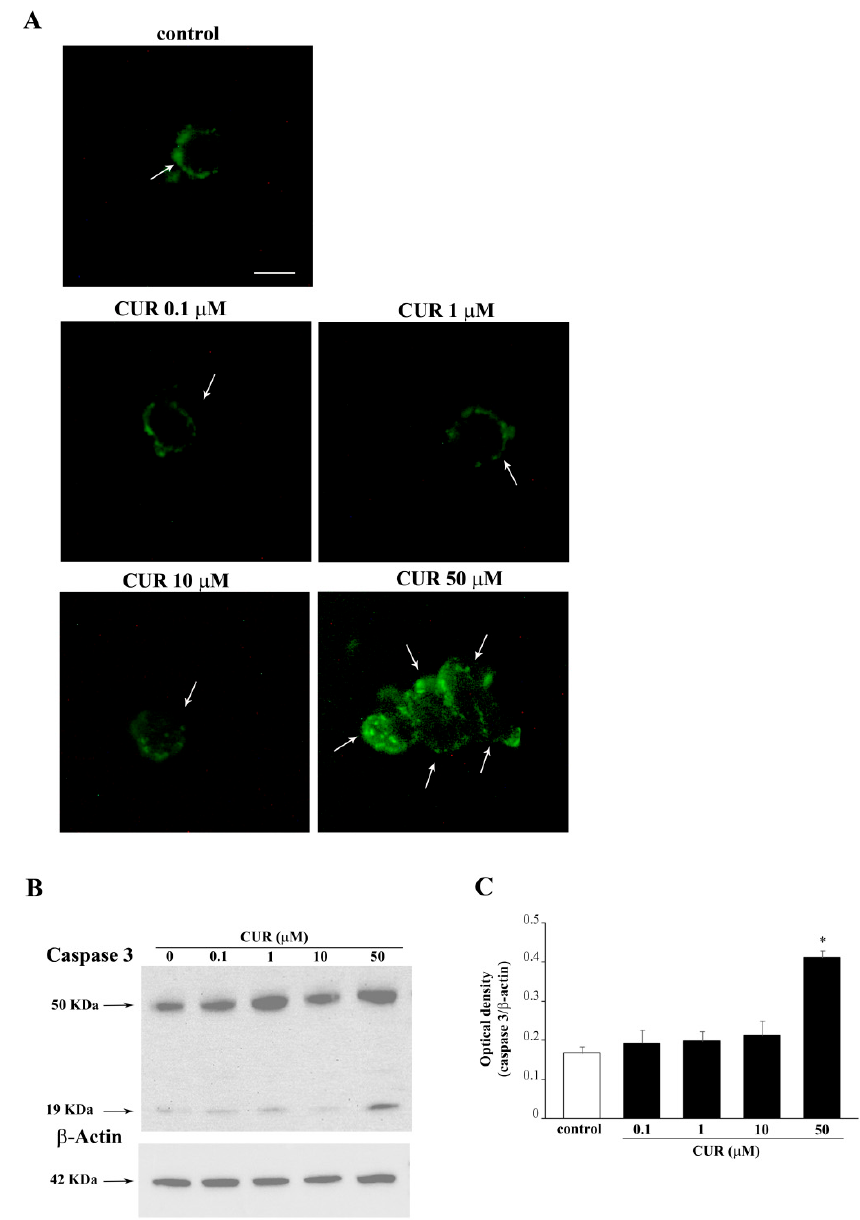
Figure 4. CUR 50 µ M increases the cleaved form of caspase 3. ( A ) Representative pictures showing caspase 3-immunofluorescent PC12 cells after CUR administration ranging from 0.1 µ M up to 50 µ M for 72 h. Immunoblotting for caspase 3 ( B ) and the related graph reporting the optical density ( C ). The primary antibody recognizes the cleaved form of caspase 3. Blot at 50 kDa represents non- specific caspase 3 substrates which are also detected at WB. Arrows indicate caspase 3 positive cells. * p ≤ 0.05 compared with control. Scale bar = 7.3 μ M.